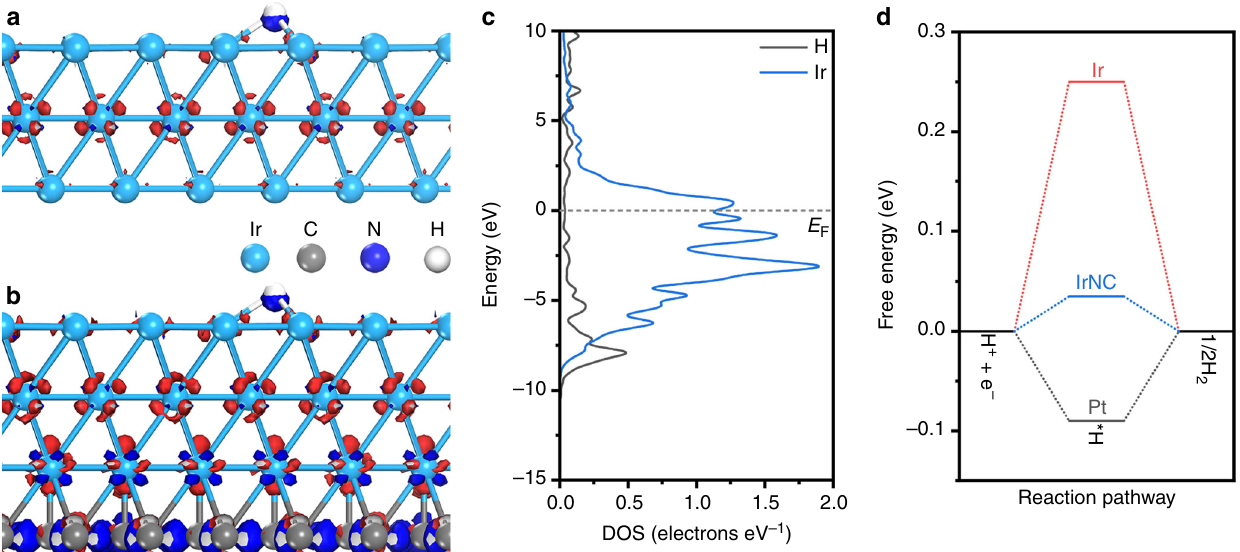
Fig. 3 Theoretical calculations of the hydrogen adsorption con fi gured for Ir and IrNC. a , b The isosurfaces of the electron density difference for Ir and IrNC with H adsorption, respectively. c The projected density of states (DOS) distribution of adsorbed H and sur fi cial Ir sites in IrNC, respectively. d The calculated free energy diagram of HER on the surface of Ir and IrNC at the equilibrium potential,